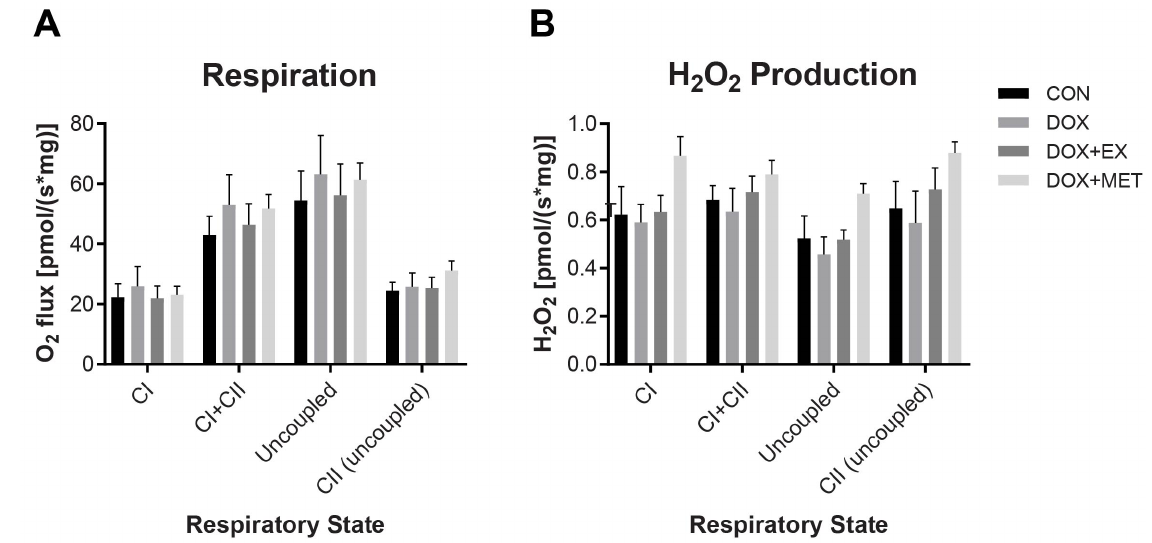
Figure 3. The respiratory capacity and H 2 O 2 production using permeabilized fibers from red gastrocnemius muscle. ( A ) The respiratory capacity of fibers following the addition of glutamate, malate, and ADP (CI), succinate (CI + CII), FCCP (Uncoupled) and rotenone (CII (uncoupled)) ( n = 6–9). ( B ) H 2 O 2 production under the same conditions as respiratory capacity measurements ( n = 3–6). No statistical differences are